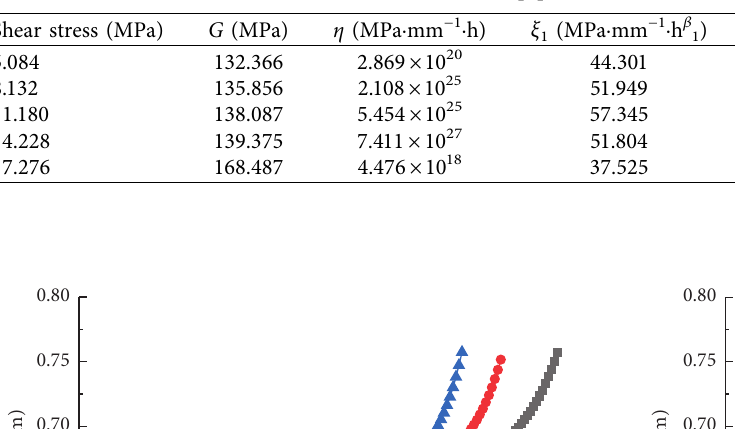
Table 1: Creep parameter identification results.